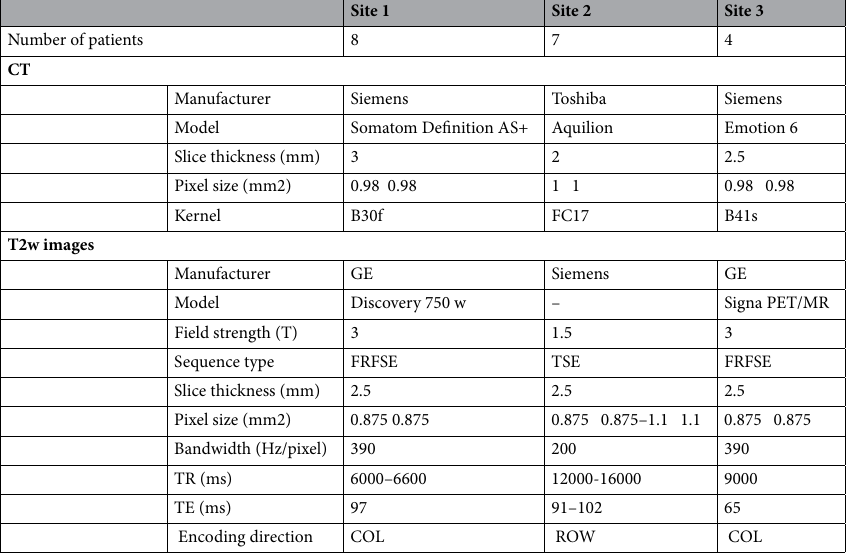
Table 1. Acquisition parameters for the different